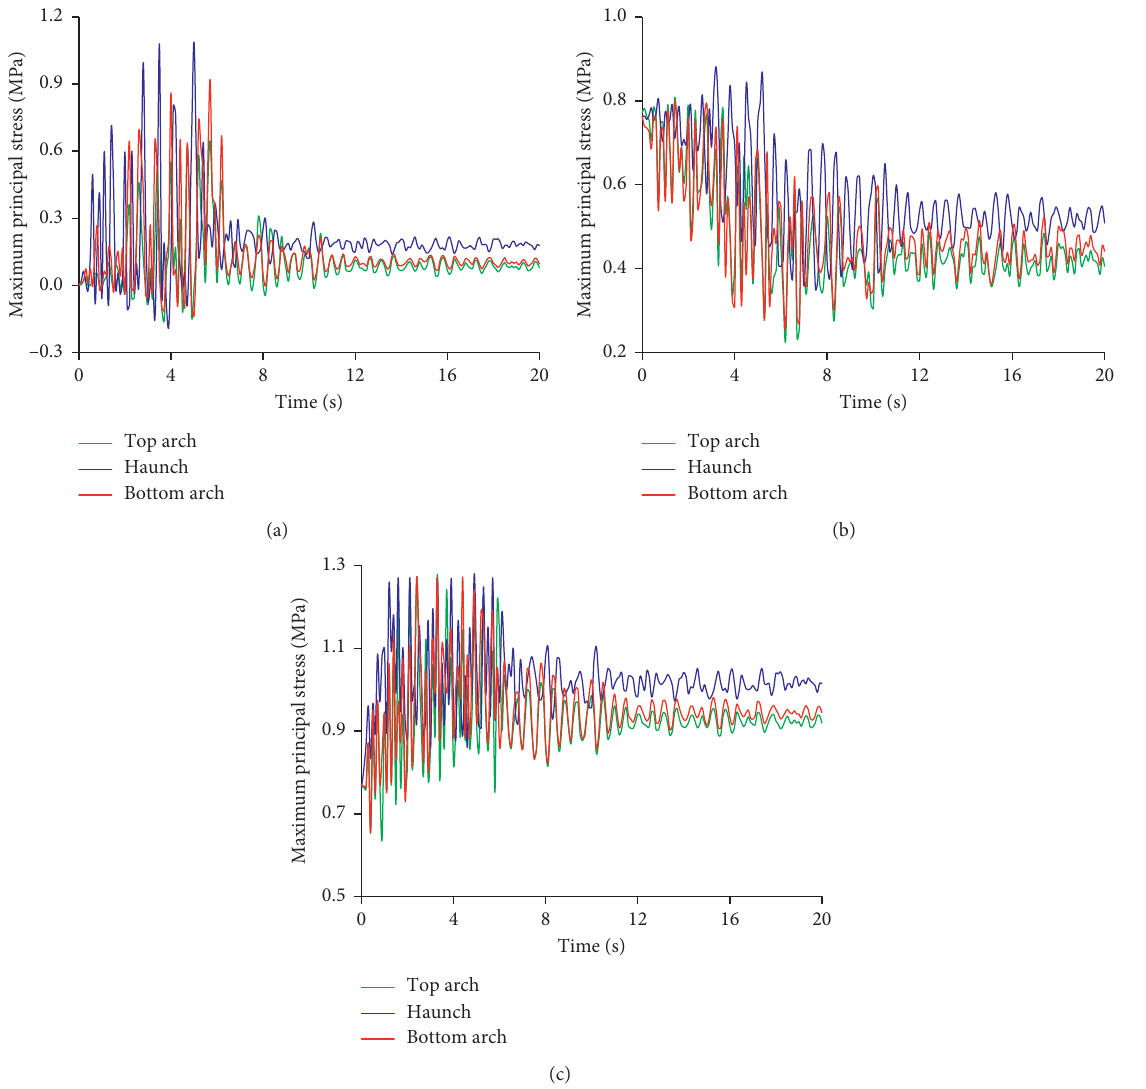
Figure 7: Maximum principal stress time-history of monitoring points. (a) Condition (1). (b) Condition (2). (c) Condition